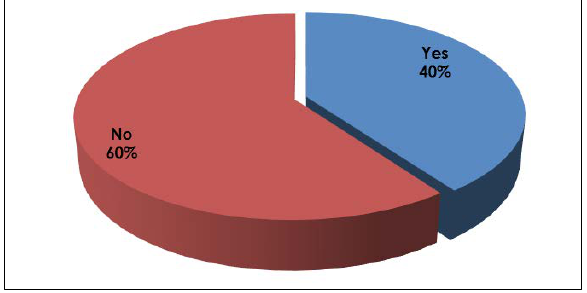
Percentage of respondents who indicated that their university had a sexual harassment policy and those who indicated ‘no’, despite all universities having such a